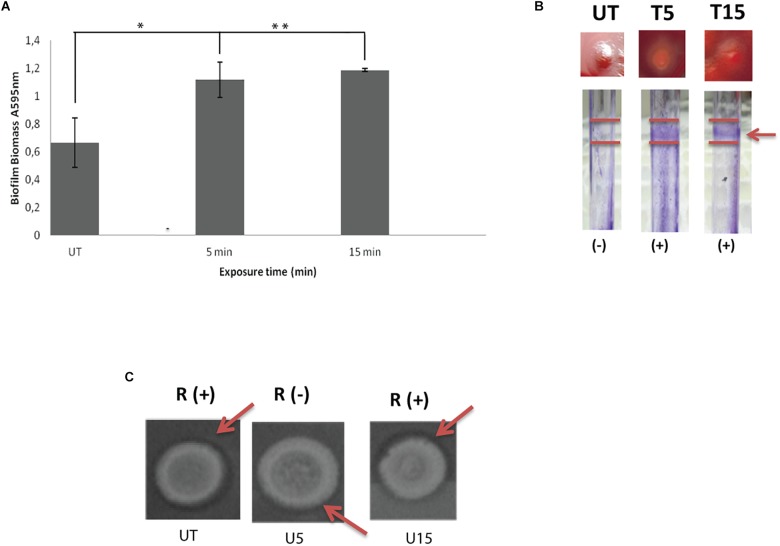
Influence of UVc treatment on biofilm biomass (A), CRA binding and glass tubes assay (B), and rhamnolipid production (C). (A) Results are shown for biofilm formation (A595 nm of crystal violet as an indirect measure of biofilm biomass). Biofilms were grown for 48 h at 37°C. UT: untreated bacteria, T5: 5 min of UVc treatment, T15min: 15 min of UVc treatment. Error bars represent the standard errors of the means for a representative assay performed in triplicate. (∗) shows significant difference (P < 0.05) for each exposure time and (∗∗) shows no significant difference. (B) In wells photographs, (-) indicates lack of pellicles and (+) indicates presence of pellicles. The arrow shows the pellicle. (C) In rhamnolipid test, a dark halo surrounding the colonies on the test plate indicates rhamnolipid production. R (+) indicates positive rhamnolipid production and R (-) indicates a reduced rhamnolipid production. Arrows show the halo surrounding the colony.